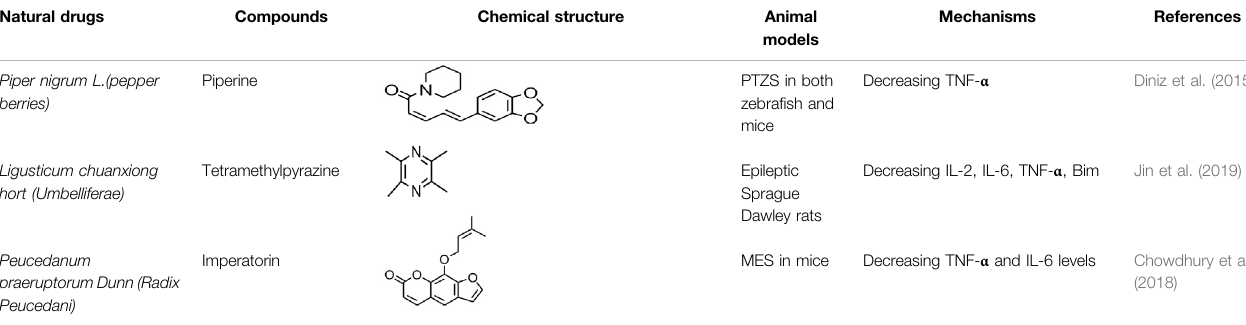
Frontiers in Pharmacology |